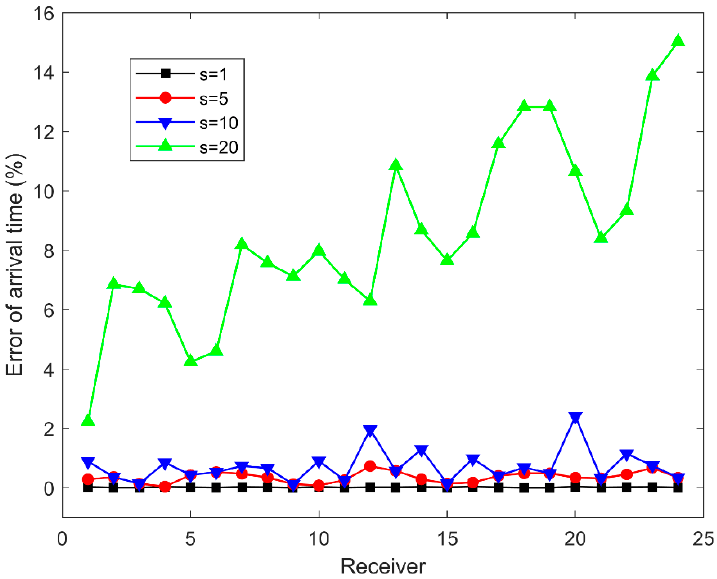
Figure 13. The relative error of the arrival time of the different step size s compared to the analysis solution.